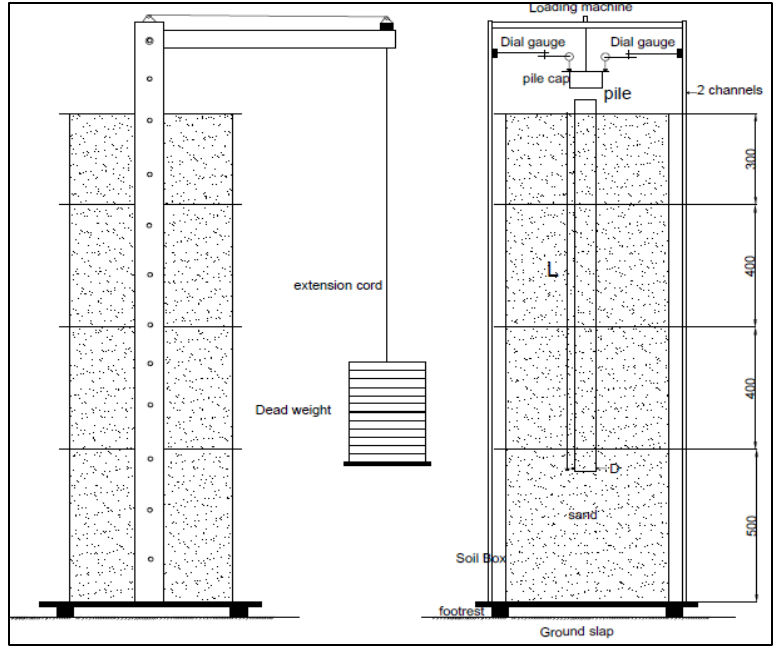
Fig. 1. The typical diagram of the test